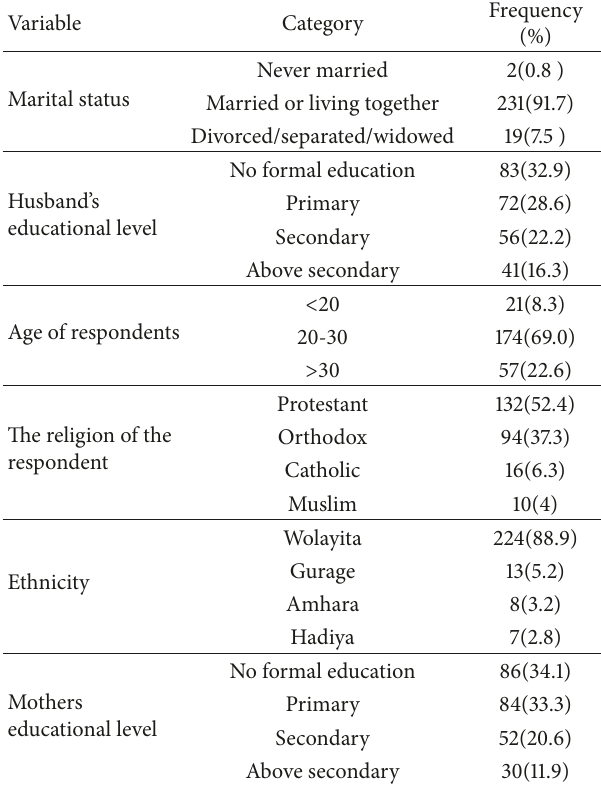
Table 1: Sociodemographic characteristics of mothers visiting health facilities in Areka town, Southern Ethiopia,